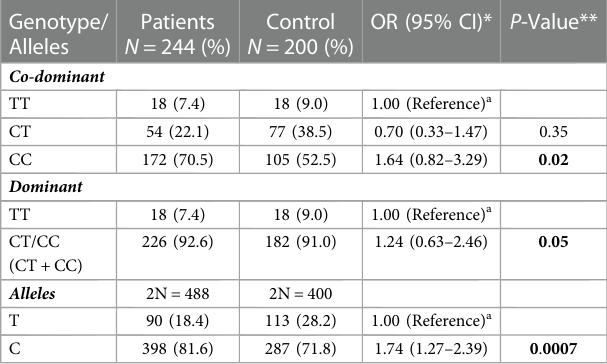
TABLE 4 Frequency of HLA DQ genotypes in Kuwaiti T1DM patients and controls. The genotypes were determined by using PCR-SSP method (Dynal kits, Oslo, Norway) as described in Materials and Methods.